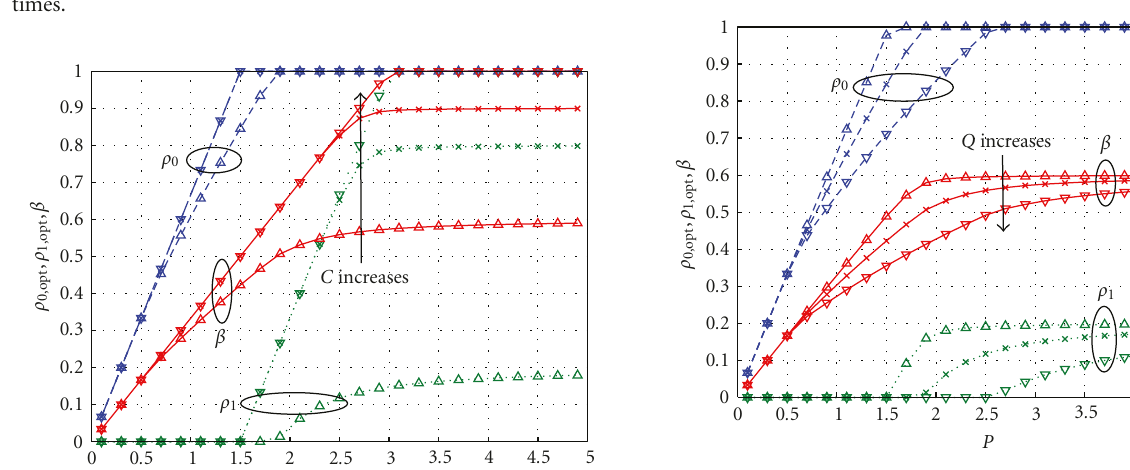
Figure 14: The optimal ρ 0 , ρ 1 , β under policy π 2 for di ff erent